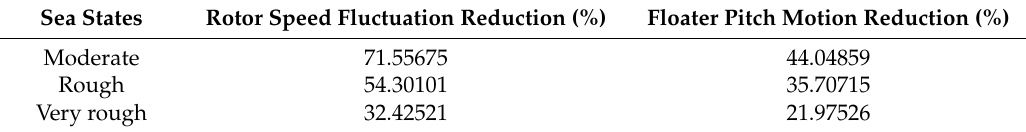
Table 4. Reduction of floater-turbine motions due to LQ control compared with PI